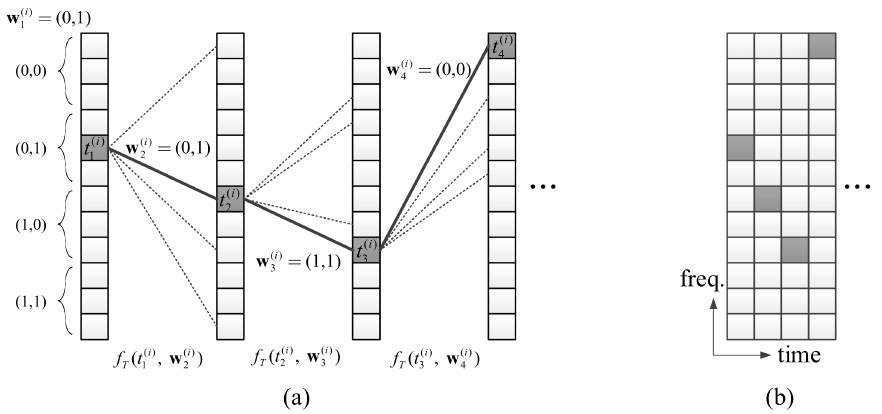
Figure 3. ( a ) Example of trellis tone modulation generated by referring to the trellis diagram in Figure 2; ( b ) Corresponding trellis tone modulation signal in orthogonal frequency division multiplexing (OFDM) resource grid.